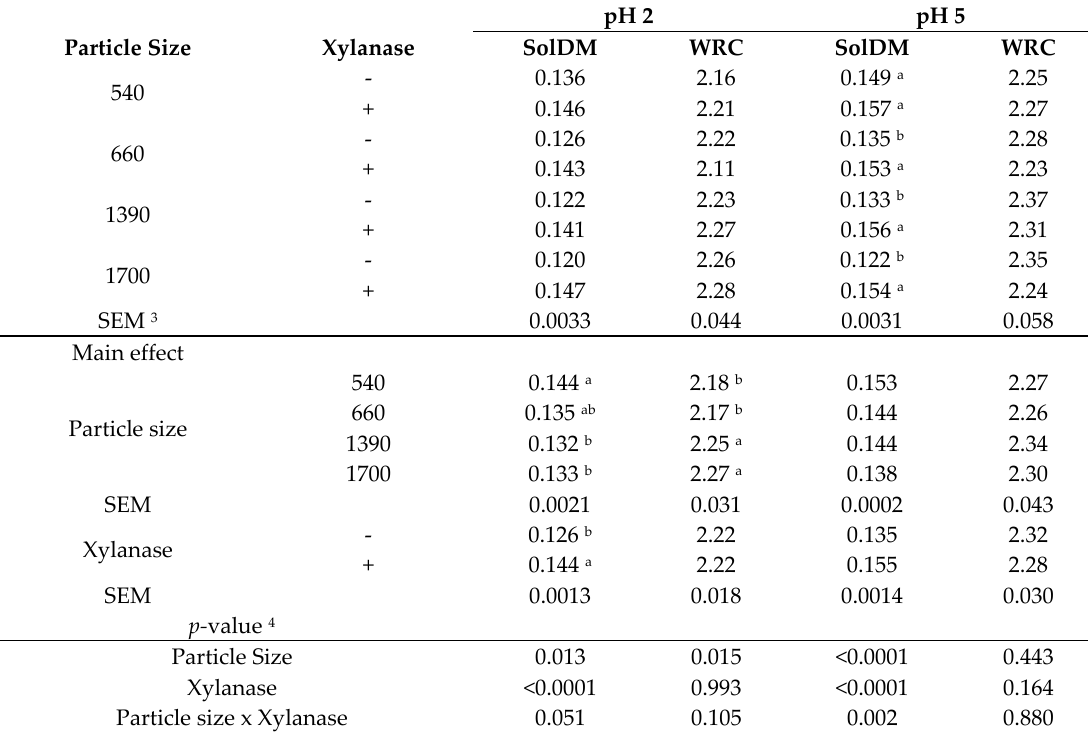
Figure 2. Effect of corn particle size on the pellet durability index ( n = 4). a,b Treatments with different letters are statistically different ( p < 0.05). Table 4. Effects of particle size and xylanase inclusion on the in-vitro analysis 1,2